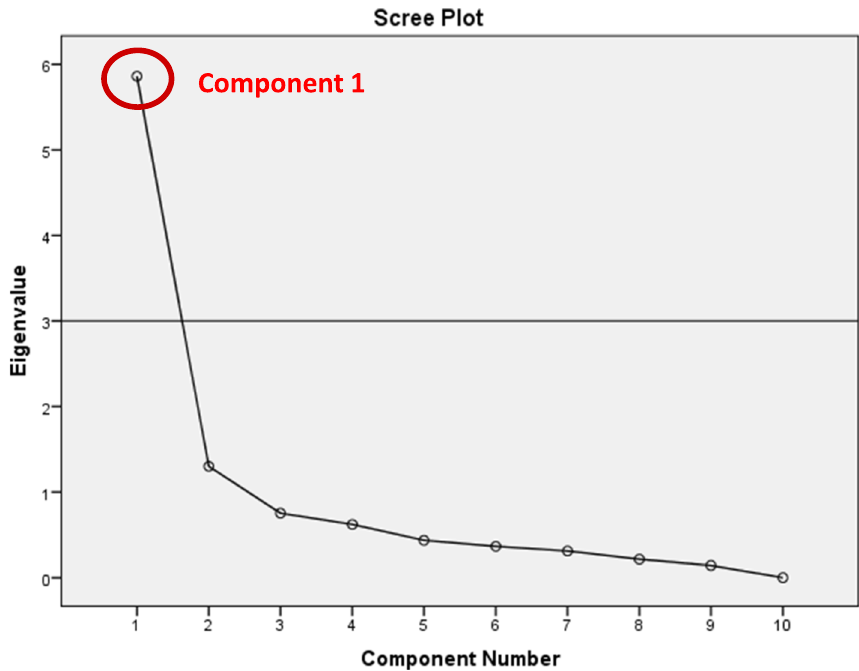
Fig. 7 Scree plot for the third runs